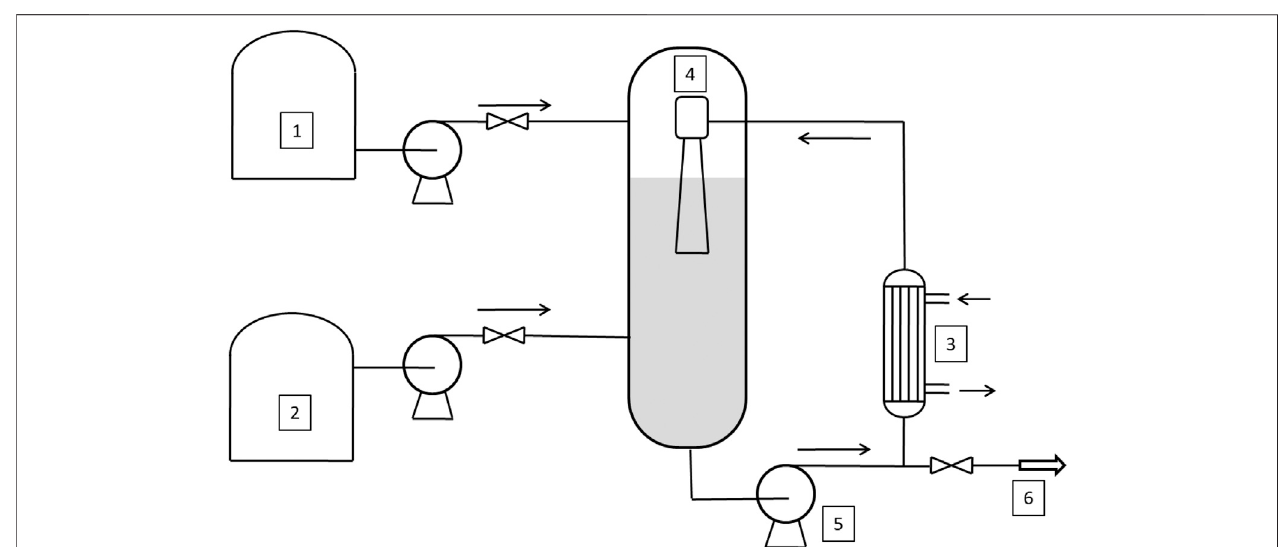
FIGURE 2 | Flowsheet of the Spray Tower Loop Reactor (STLR). 1 – 2: tanks, 3: heat exchanger; 4: spray nozzles; 5: recirculating pump; 6: outlet stream.